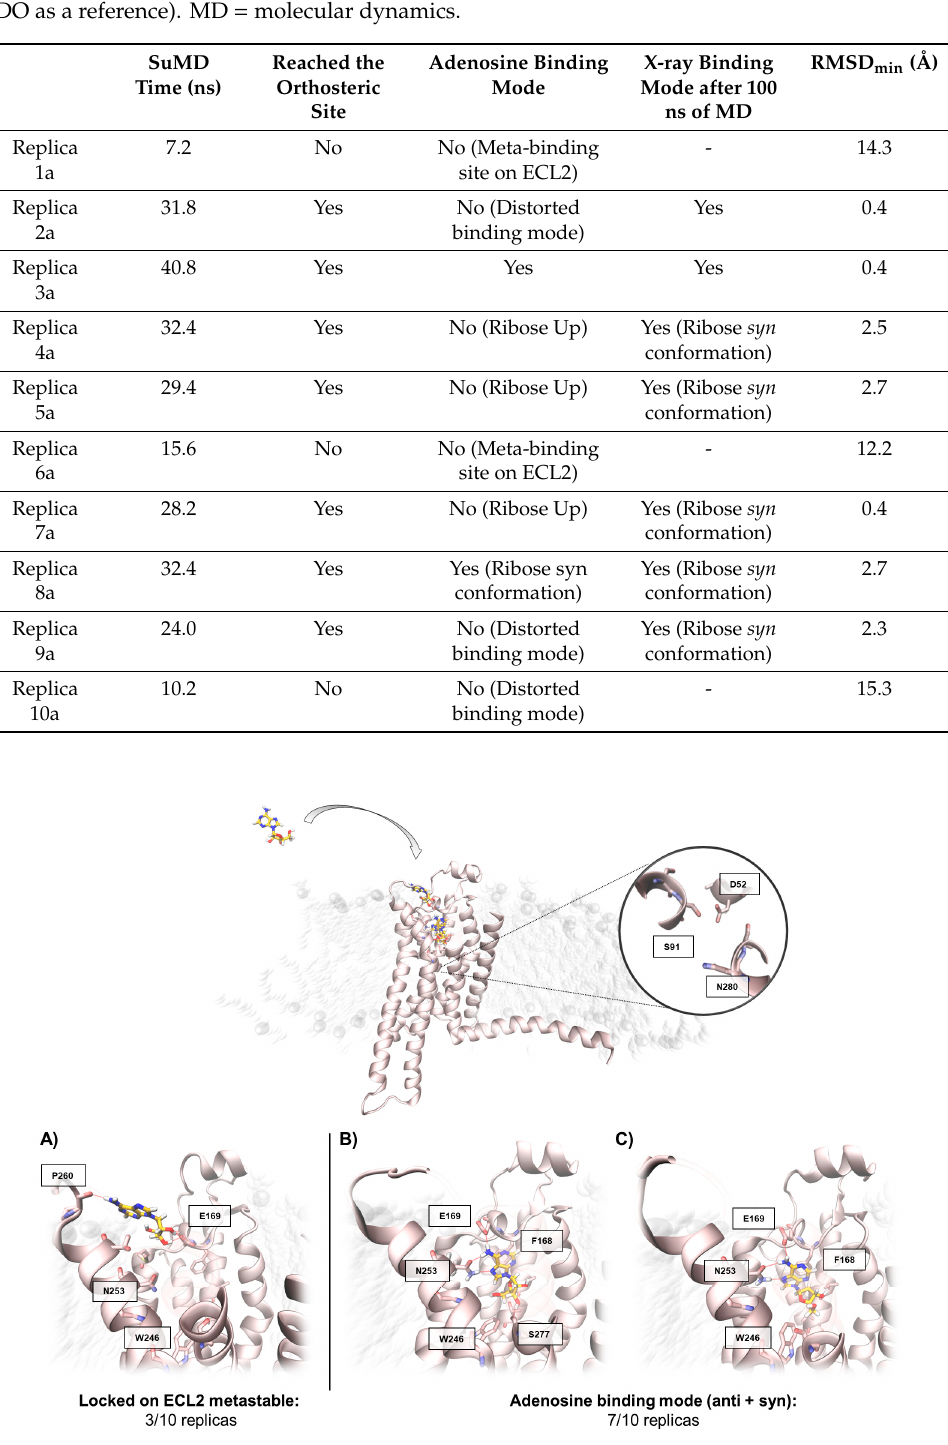
Figure 2. Conformations sampled by the adenosine while recognizing the A 2A AR in the intermediate-active state. Top, the absence of a sodium ion in the allosteric binding site is highlighted. Panel ( A ) shows a representative adenosine binding mode in the extracellular loop 2 (ECL2) metastable binding. In panels ( B , C ), the ribose in anti ( B ) and syn ( C ) conformation are reported. Only the syn orientation permits the hydrogen bonding with the residue S277 7.42 .